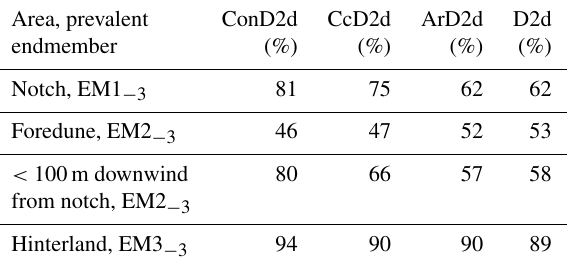
Table 3. Average endmember abundances of the dominant end- member per subregion as defined in Fig.